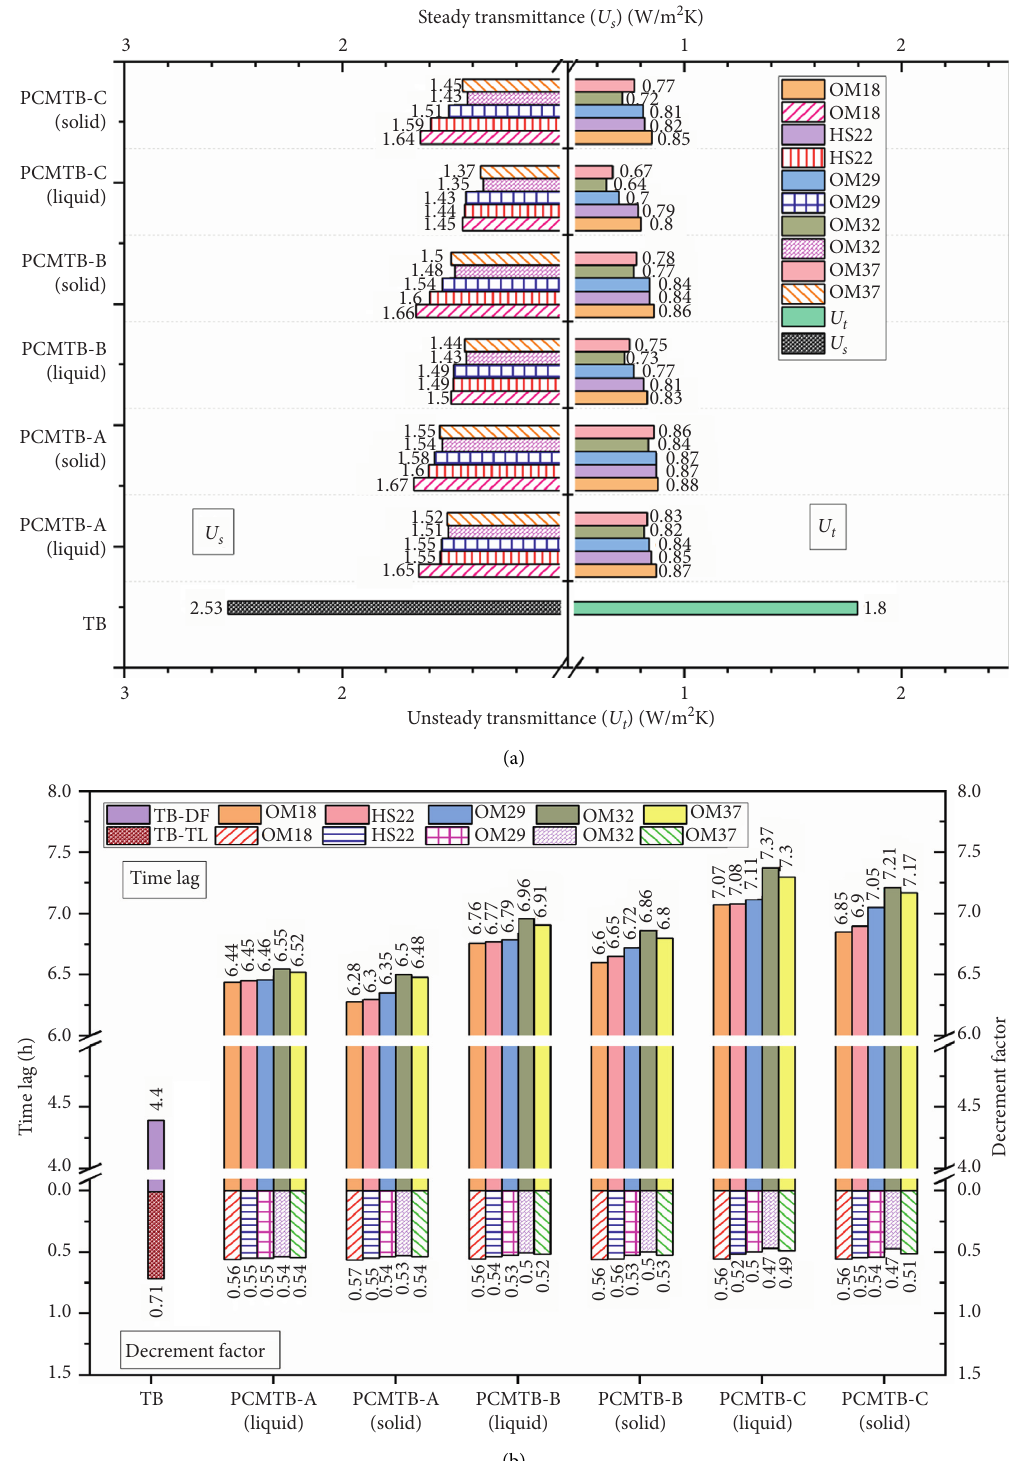
Figure 5: Thermal characteristics of terracotta bricks integrated with PCMs: (a) Steady and unsteady transmittance variations; (b) decrement factor and time lag